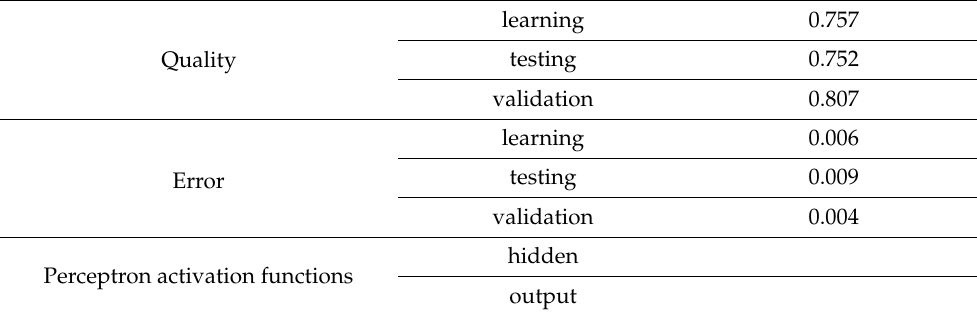
Table 4. Analysis of quality and errors of the MLP 9-4-1.